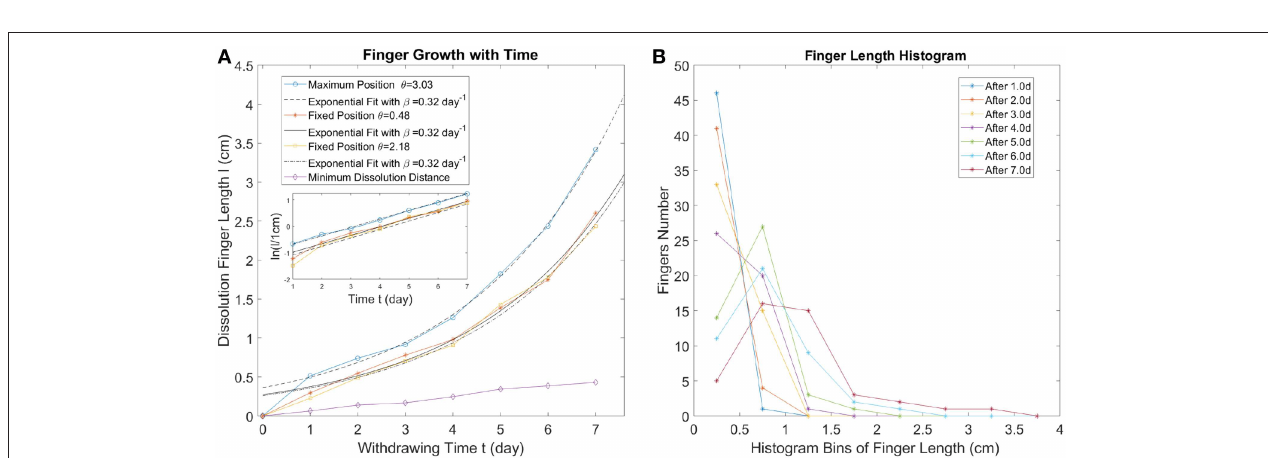
FIGURE 4 | (A) The finger length evolution with time. The longest finger and two second longest fingers growth with time are displayed. Fingers located at different angular positions (see Figure 3B ) are represented by different colors. The finger growth with time at these positions (fixed θ ) have been fitted with an exponential function l = a · e β t , displayed by three different black curves (solid or dashed). Minimum dissolution distance (corresponding to the point on the perimeter with the slowest dissolution speed) is shown by the purple curve. The inset shows the exponential fits for the finger length vs. time. (B) Dissolution finger length histograms obtained by counting the peaks in the dissolution length profiles (see Figure 3B ). Different colors represent different times. The histogram bins cover the range 0–4.0 cm with bin size 0.5